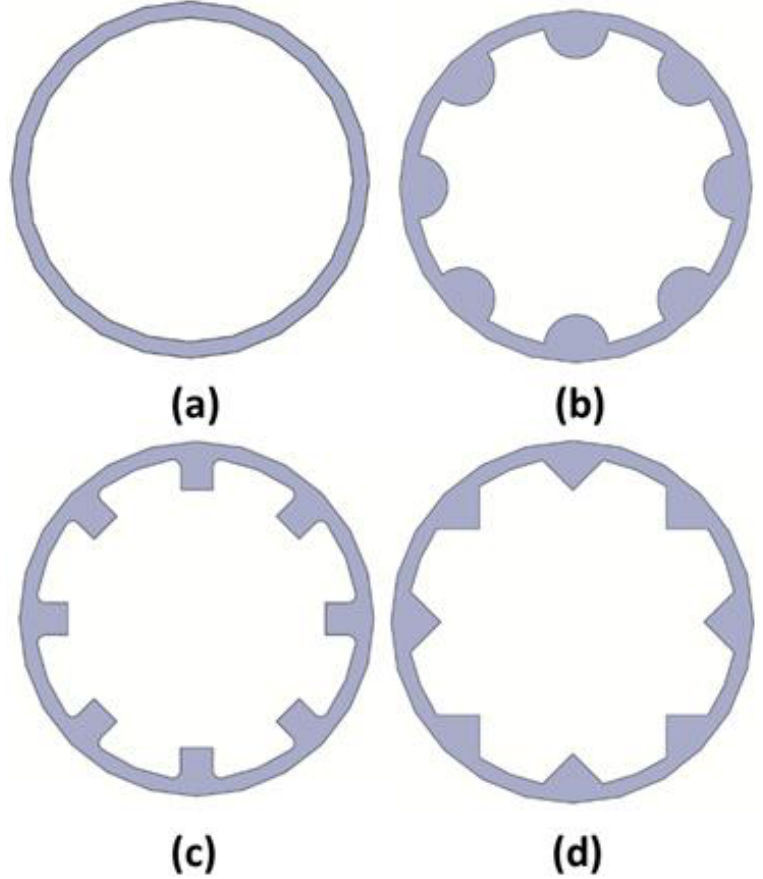
Figure 2. The studied cross-sections of the tube: ( a ) reference empty tube, ( b ) tube with circular fins, ( c ) tube with rectangular fines, and ( d ) tube with triangular fins.